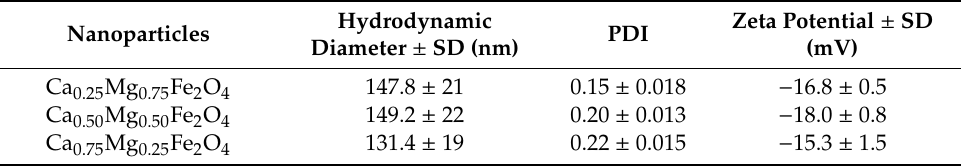
Table 3. Hydrodynamic size, polydispersity, and zeta potential of egg–phosphatidylcholine (Egg–PC) aqueous magnetoliposomes containing calcium-substituted magnesium ferrite nanoparticles. (SD: standard deviation; PDI: Polydispersity